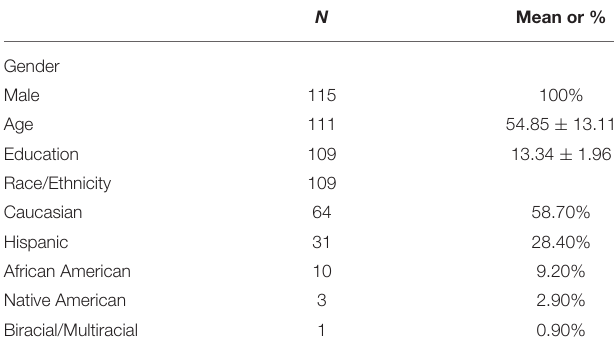
TABLE 1 | Demographic characteristics.